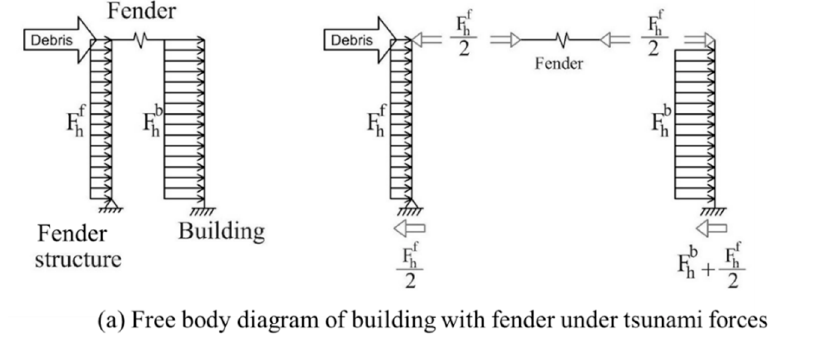
Figure 21. Idealization of the building without a fender structure.